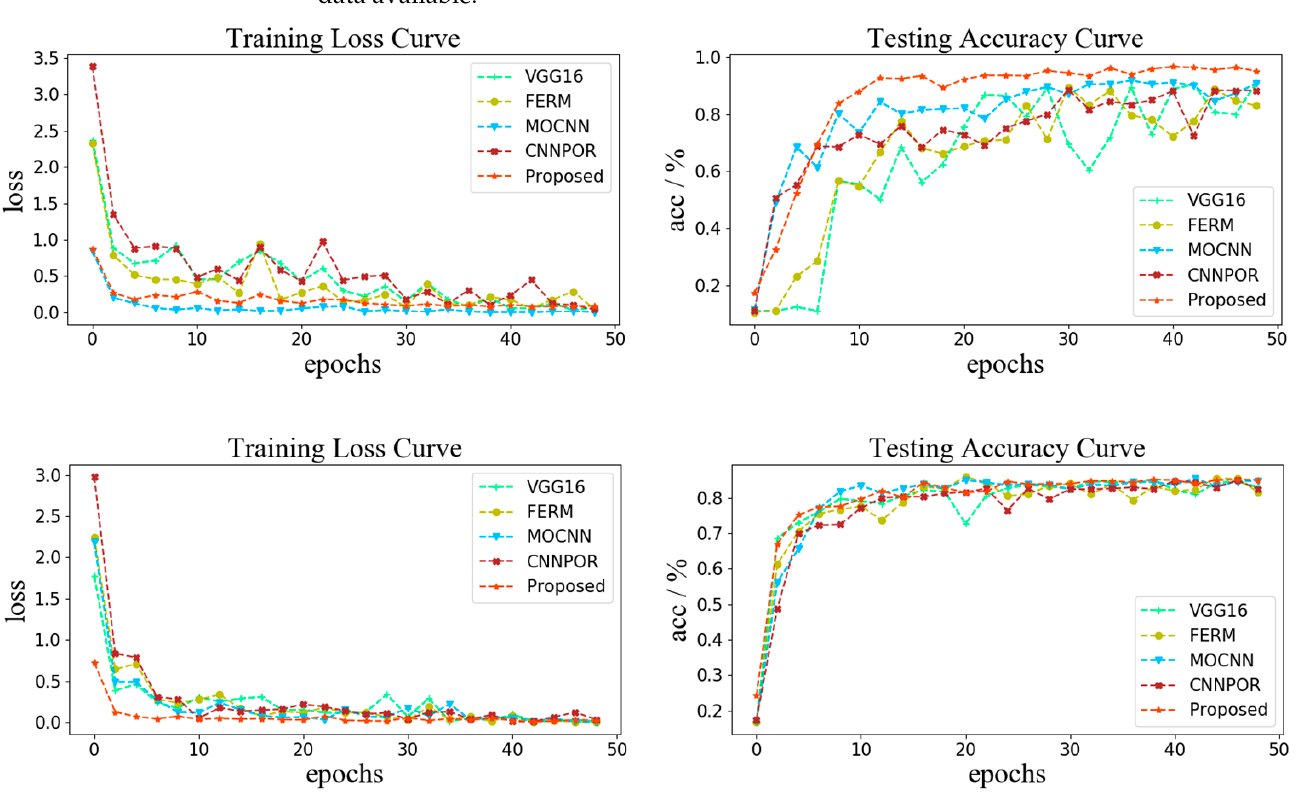
Figure 7. The upper part shows the training loss and testing accuracy with the ExFRIDA dataset, and the lower part shows the training loss and testing accuracy with the FHVI dataset.